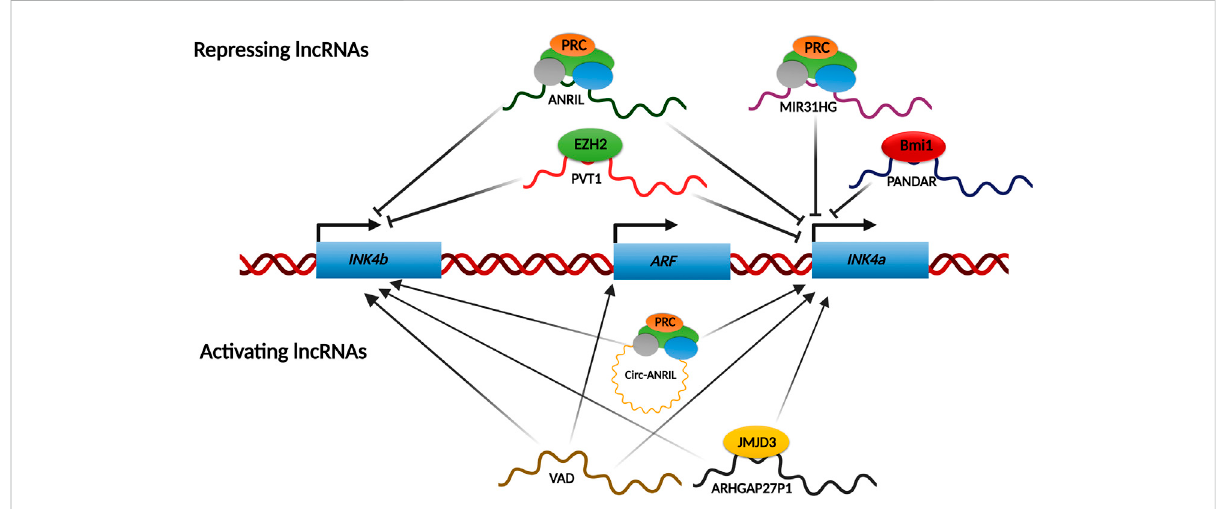
FIGURE 5 lncRNAs network regulating INK4/ARF locus. Various lncRNAs regulate the INK4a/ARF locus under certain conditions. Most of the known regulatorylncRNAsshutdownthetranscriptionfromthislocusbyrecruitingPcGsontothepromoters.However,somelncRNAshavebeenshownto activate this locus transcriptionally by either recruiting chromatin modi fi ers such as JMJD3 onto the promoters or by removing the repressive complexes like PcGs from the